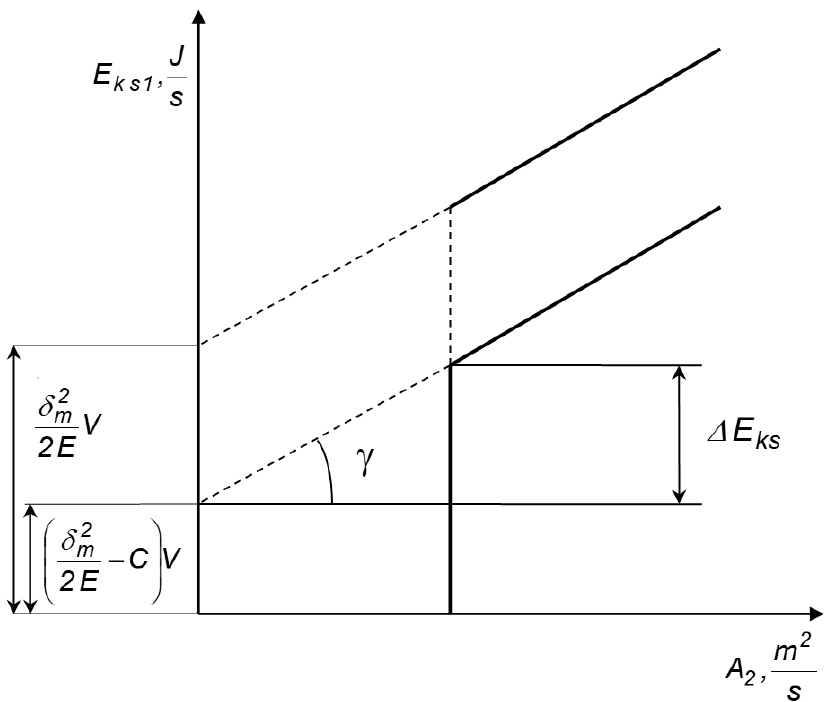
Figure 1. Scheme for determining the elastic limit stress values and the surface density of the grinding energy .